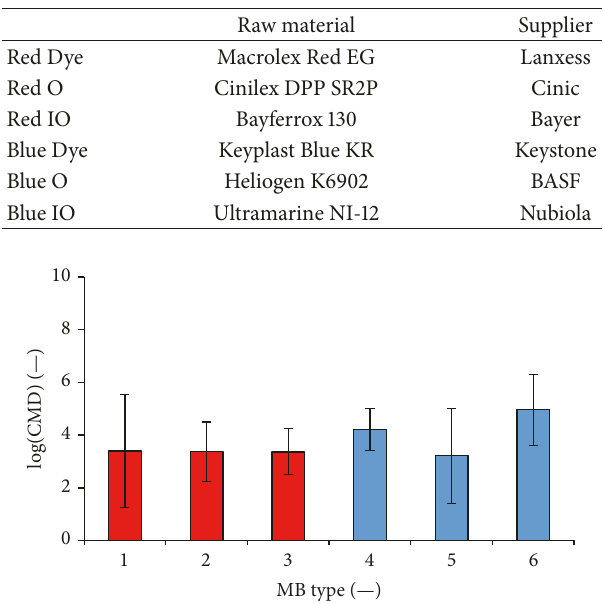
Table 2: The types and suppliers of the tested coloring agents.